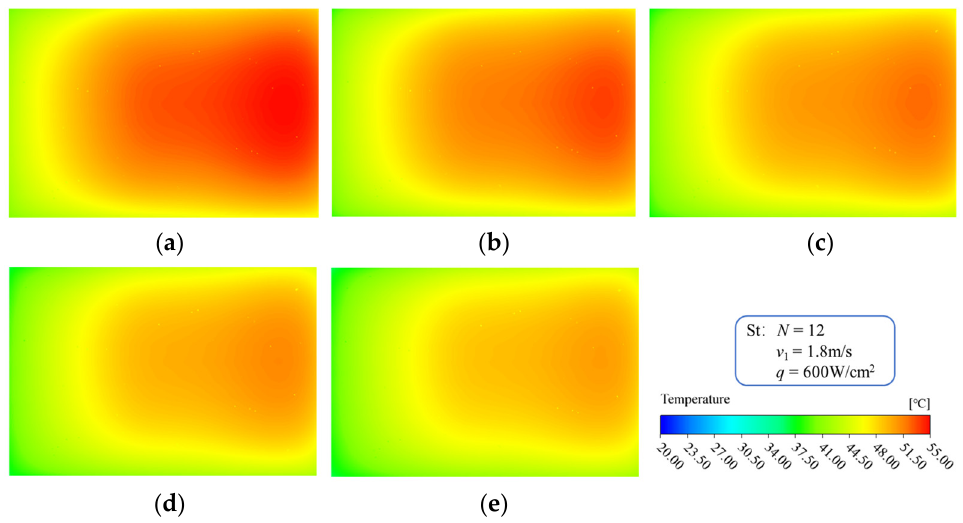
Figure 10. Temperature distribution of heating surface at different inlet − 2 velocities. ( a ) u in − 2 = 1.2 m/s; ( b ) u in − 2 = 1.5 m/s; ( c ) u in − 2 = 1.8 m/s; ( d ) u in − 2 = 2.1 m/s; ( e ) u in − 2 = 2.4 m/s.